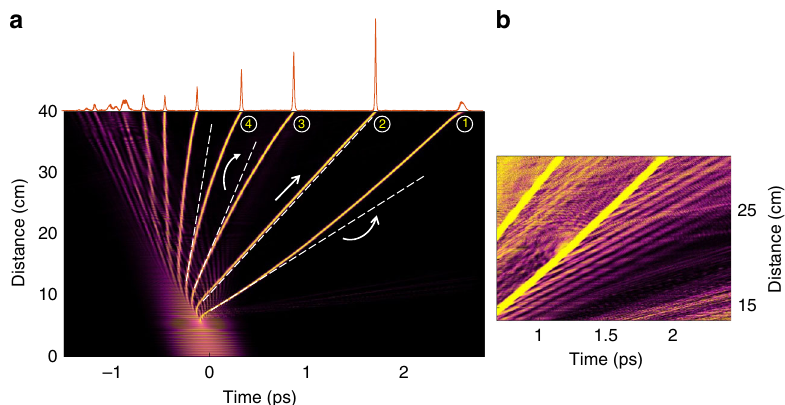
Fig. 4 Temporal evolution of a 400-fs pulse at 1550 nm in a tapered multimode fi ber as obtained from a generalized Unidirectional Pulse Propagation Equation simulation. a Generation and propagation of multimode solitons are displayed in a co-moving temporal window. The parameters used are 400-fs pulse at a wavelength of 1550 nm with a peak power of ~50 kW, injected in a 40 cm long tapered multimode fi ber, whose core radius decreases from 40 to 10 µ m. The multimode solitons exhibit radically different behaviors as they propagate through the tapered section. The trajectory of the slowest soliton (#1) has a positive curvature, signifying a speed up during propagation. The second soliton (#2) has a zero temporal curvature (and thus no temporal acceleration), while all the subsequent solitons are decelerating. The dashed lines are tangential to the soliton trajectory and represent the instantaneous velocity of the multimode solitons right after soliton fi ssion. b A closer look at the trajectory of the fi rst emitted soliton (#1) reveals an emission of dispersive waves as these solitons are continuously perturbed in the tapering section. Because of these dispersive waves, the fi rst soliton experiences a slight bend toward earlier times and hence travels faster